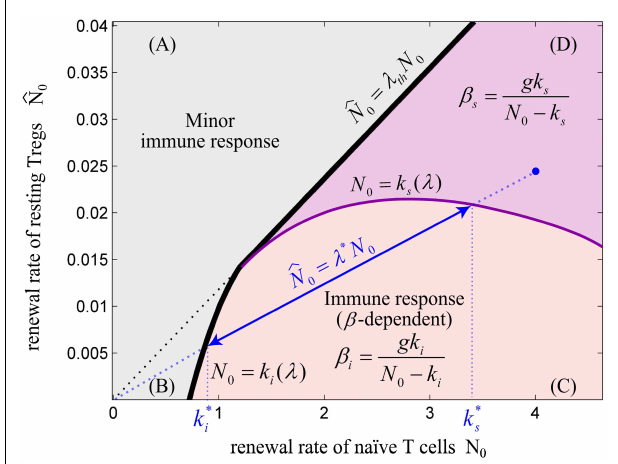
FIGURE 6 |The balance between renewal rate of naïve T cells and restingTregs .The relative renewal rate of naïve T cells and restingTregs (λ = (cid:98) N / N ) determines the existence of an immune response.The 0 0 initiation of an immune response requires a sufficient renewal rate of naïve T cells ( N 0 ). (A) For λ>λ th , the immune response does not exist for any value of N 0 and Ag-stimulation ( β ). (B) For N 0 < k i , no immune response can be initiated for any value of β . (C) For N 0 > k i , immune response can be initiated for β >β i . In this regime, the Ag-stimulation that results in over-suppression of immune response ( β s ) does not exist. (D) In this regime, immune response is initiated for β >β i , and is over-suppressed for β >β λ . For any point in s . Note that k i and k s are dependent on the value of the plane (e.g., blue point), the values of k ∗ and k ∗ are obtained by s i projecting the intersections of the line created by connecting the point to the origin (slope = λ *) with the nonlinear curves N 0 = k i ( λ ) and N 0 = k s ( λ ) onto the N 0 -axis. By decreasing λ * , the effective range of T cell activation ( k ∗ ) or equivalently, the effective range of Ag-stimulation (β ∗ ) − k ∗ − β ∗ s i s i which evoke immune response without over-suppression increases.We hypothesize that a healthy individual bears the potential to evoke self reaction and therefore its immune system is located in parametric regime (C) or (D) ; however, higher self Ag-stimulation compared to nonself Ag-stimulation is required for initiating immune response due to